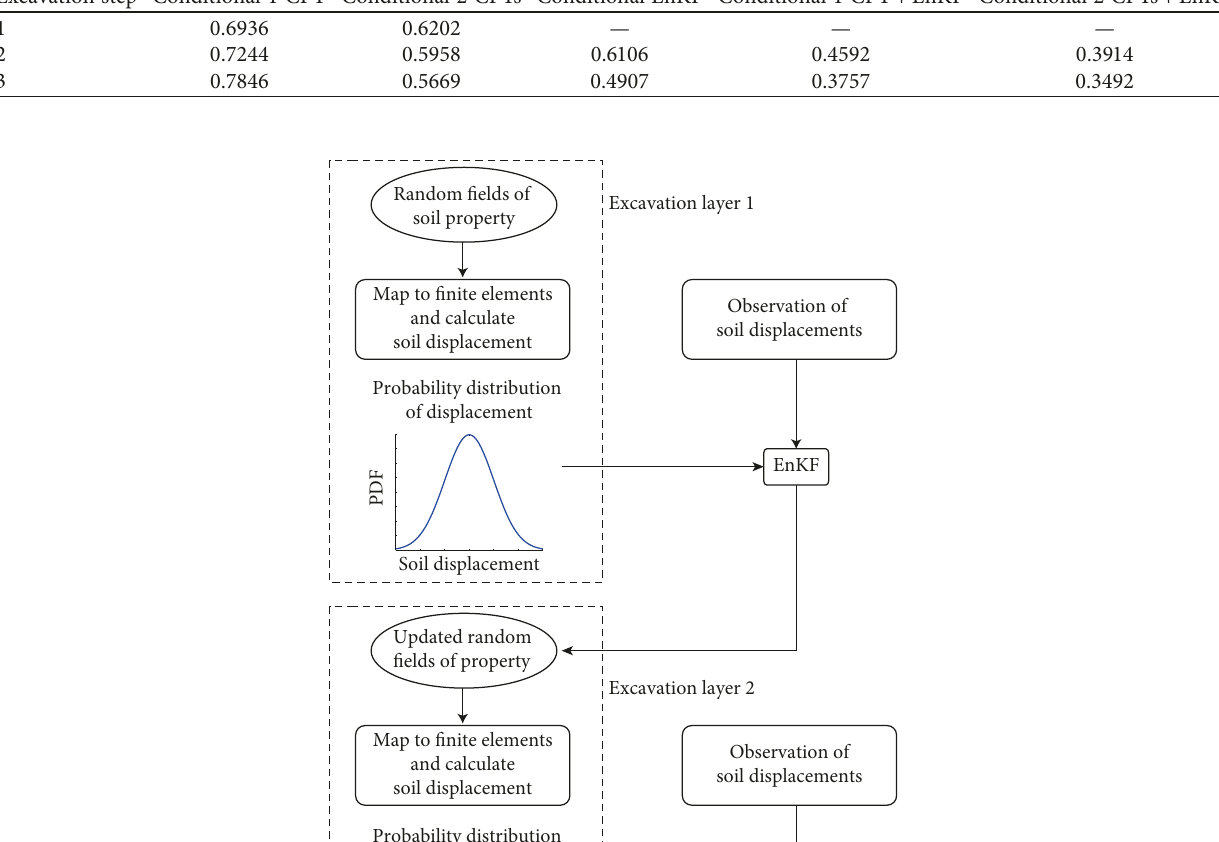
in Y displacements. d